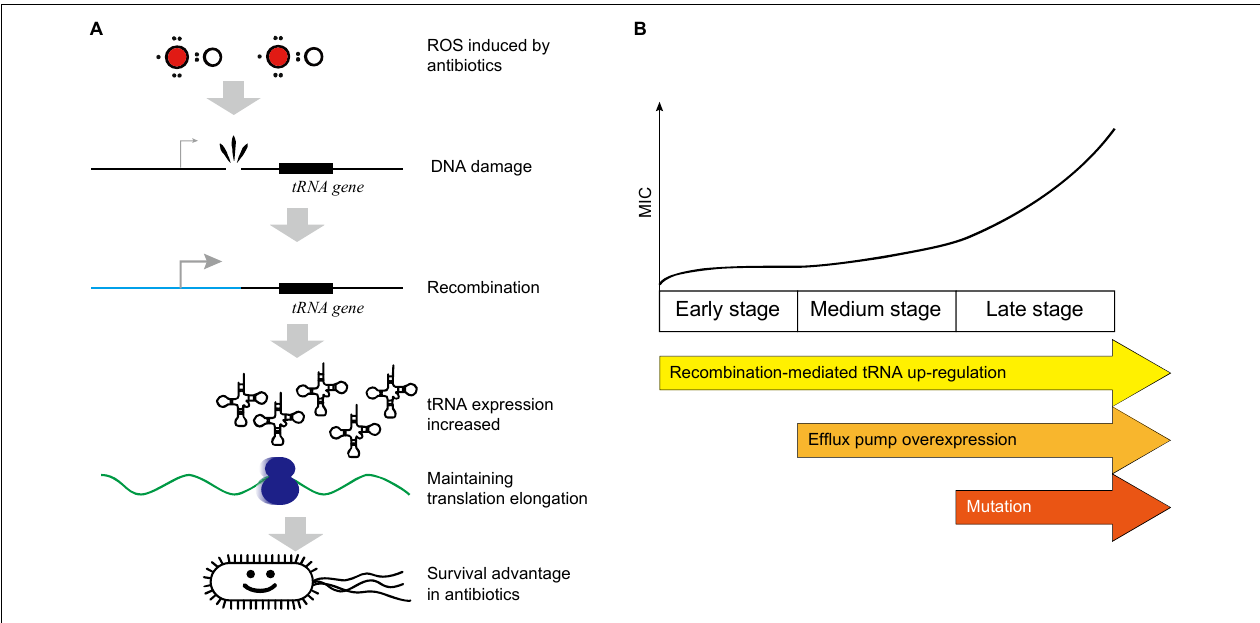
FIGURE 6 | Scheme of the recombination-mediated tRNA up-regulation. (A) Pathway illustration of the recombination-mediated tRNA up-regulation. (B) Multiple AR mechanisms coordinate in a stepwise